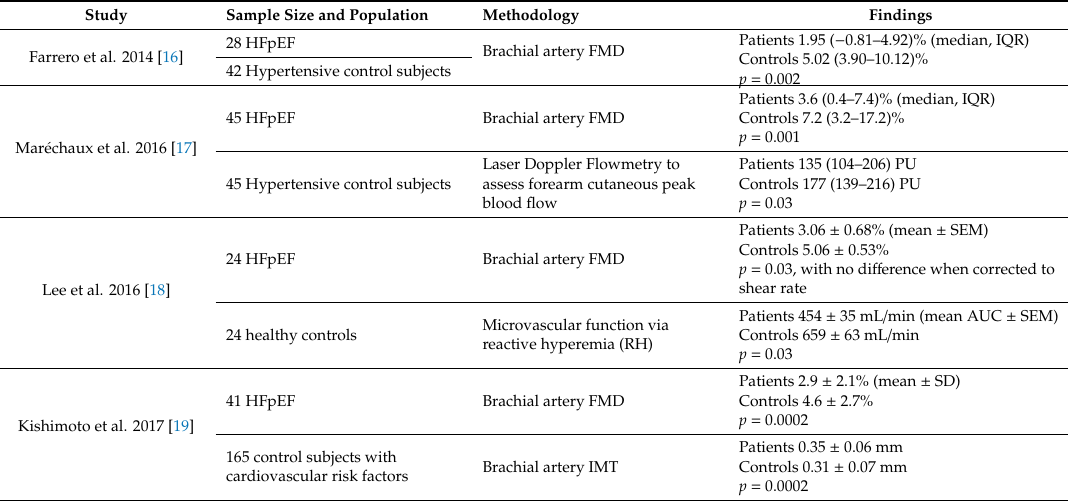
Table 1. Studies that assessed endothelial dysfunction in patients with heart failure with preserved ejection fraction